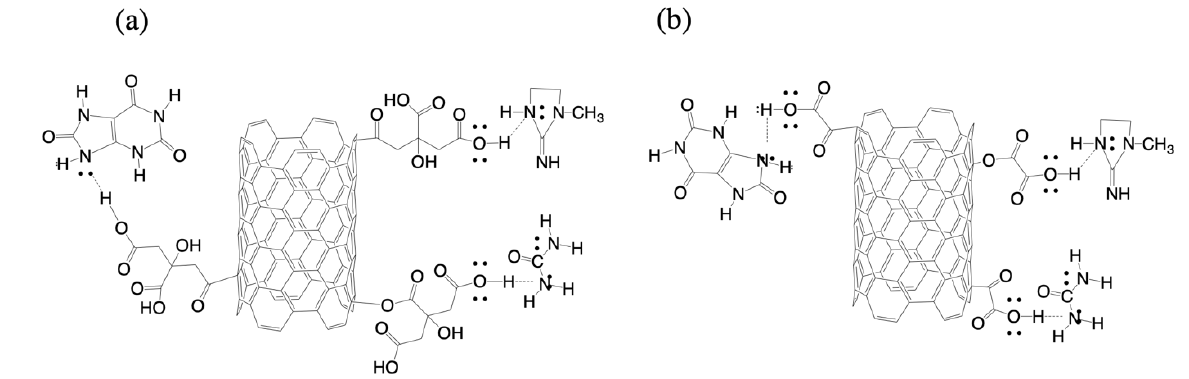
Figure 9. Possible interaction of ( a ) MWCNT-CA and ( b ) MWCNT-OA with uremic toxins.